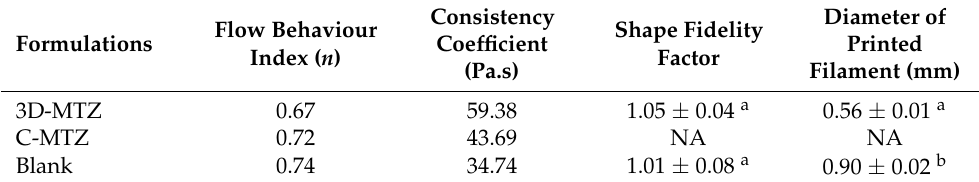
Figure 2. Rheological characteristics of HPMC E15 in different formulations: graph plotted between viscosity and shear rate with fitting power ‐ law model. Table 1. Parameters from power ‐ law model and shape fidelity factor.